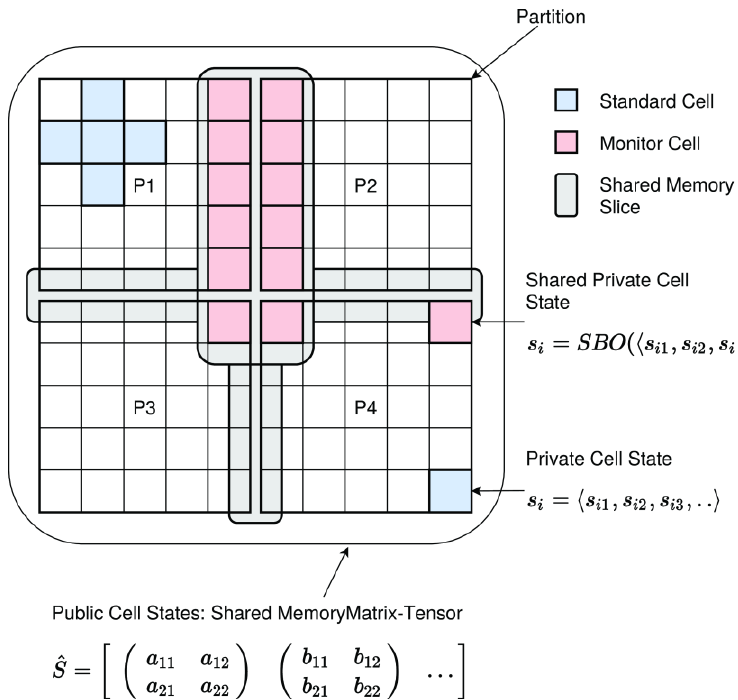
Figure 9. The basic partitioned architecture of the CA. Each partition of the CA world is executed in a separate process. Data exchange is performed via shared memory.